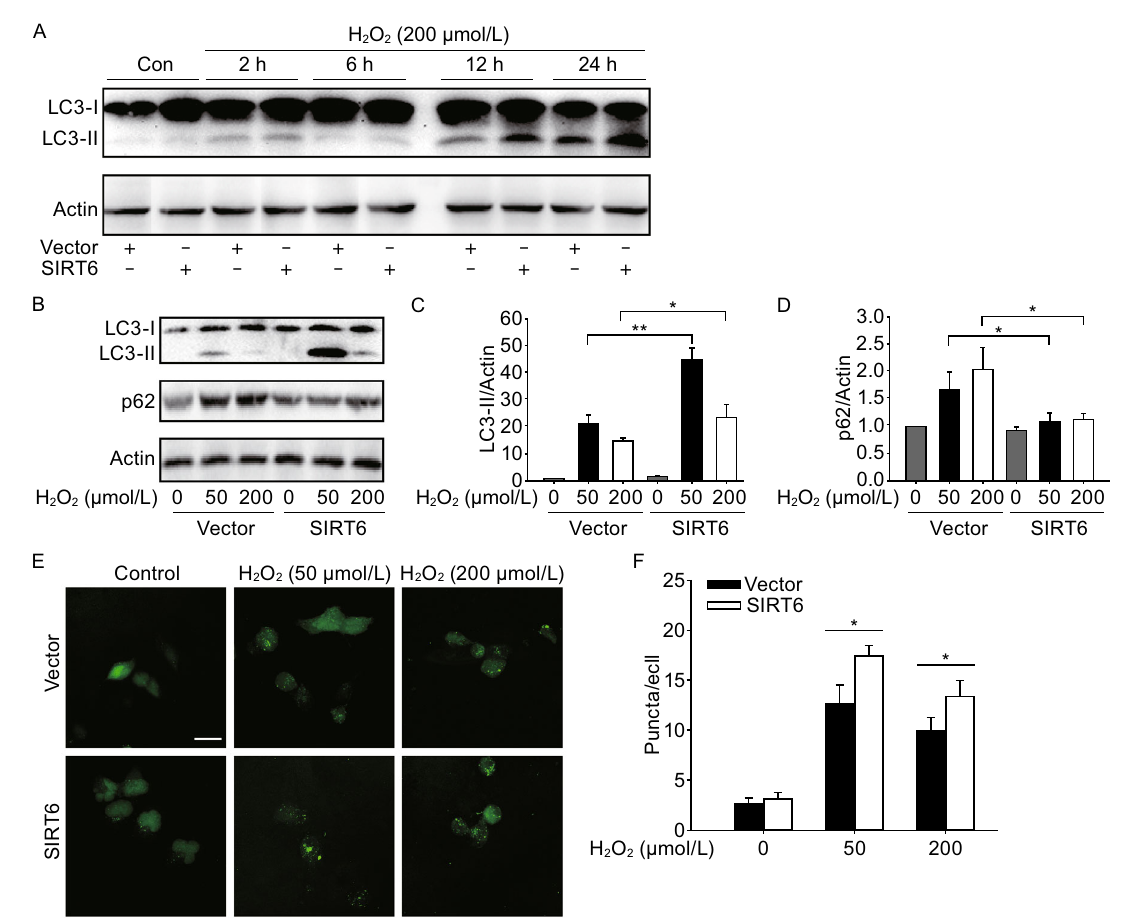
Figure 3. SIRT6 induces autophagy after H 2 O 2 treatment. (A) SH-SY5Y cells were pretreated with H 2 O 2 for 1 h and then cultured for indicated time. Cell lysates were analyzed by immunoblotting with antibodies speci fi c to LC3. (B – D) SH-SY5Y cells were pretreated with H 2 O 2 for 1 h and then cultured for 24 h. LC3 and p62 levels were analyzed by Western blot and quanti fi ed. (E and F) SH-SY5Y cells were exposed to H 2 O 2 for 1 h and then cultured for 24 h after transfection with EGFP-LC3 plasmid. Number of EGFP- LC3 puncta per cell was counted to quantify autophagosome formation. Bars represent the mean ± SEM from at least three independent experiments. Scale bar = 20 µm, * P < 0.05; ** P <